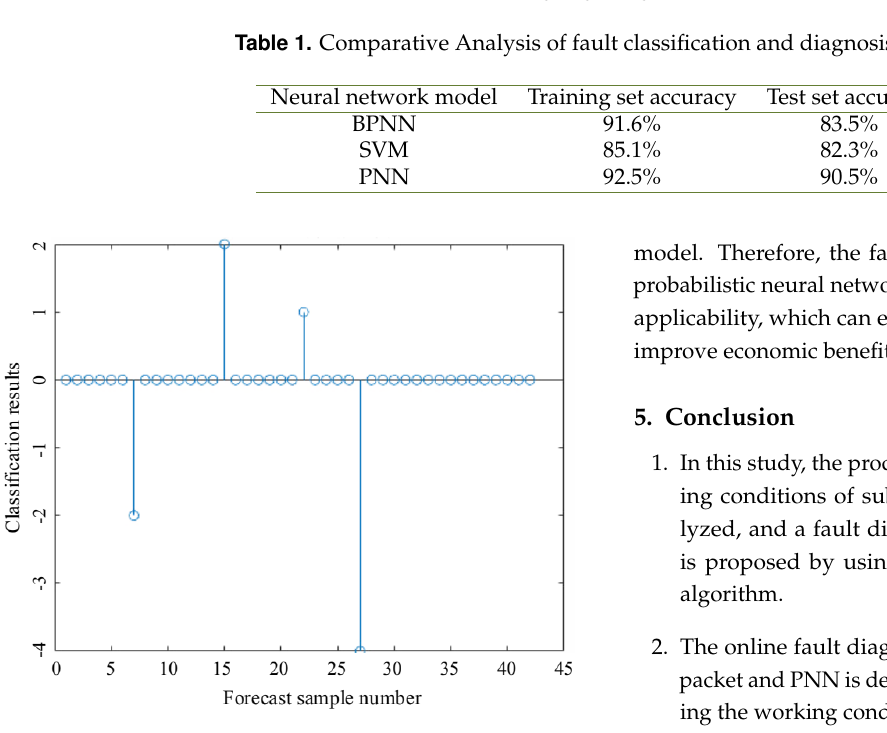
Fig. 10 is an error graph of 42 groups of test data.